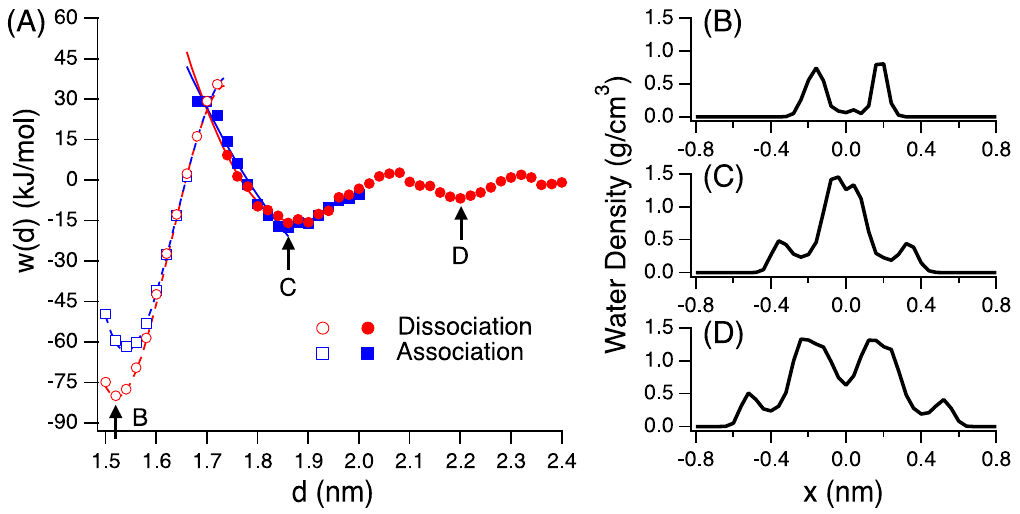
Figure 3. ( A ) Potential of mean force w ( d ) between Ri AFPs as a function of the separation d during the dissociation (blue) and association (red) processes. The dashed and solid lines represent third- and fourth-order polynomial fits, respectively. ( B ) Density profile of water confined between the two proteins at d = 1.52 nm, ( C ) 1.86 nm, and ( D ) 2.20 nm. In panels B–D, the center of the two proteins is set to x = 0.0. The typical error bars in the potential of mean force (PMF) are of the order of 5 kJ/mol.